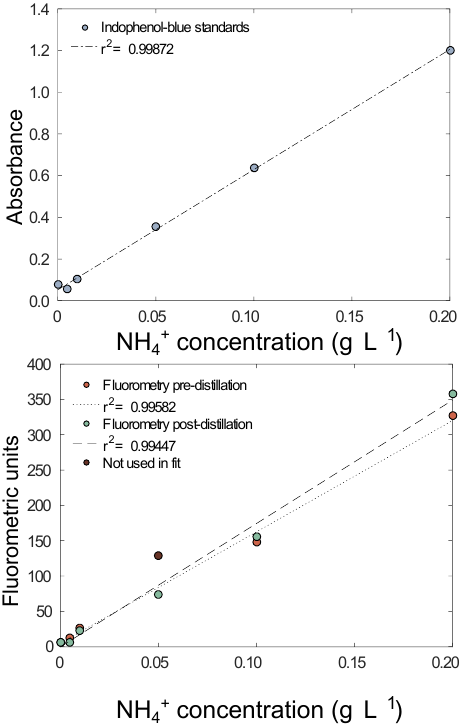
Figure 1. Example standard curves for colorimetry and fluorome- try analyses. Absorbance is the fraction of incoming light that is absorbed by the indophenol-blue solution. The value larger than 1 for 0.20gL − 1 is due to dilution for absorbance reading and correc- tion for this dilution. These standard curves were used to calculate sample values for those analyses occurring after distillation. In ad- dition, fluorometry curves show that distillation does not greatly af- fect working standards, though the same may not be true for actual